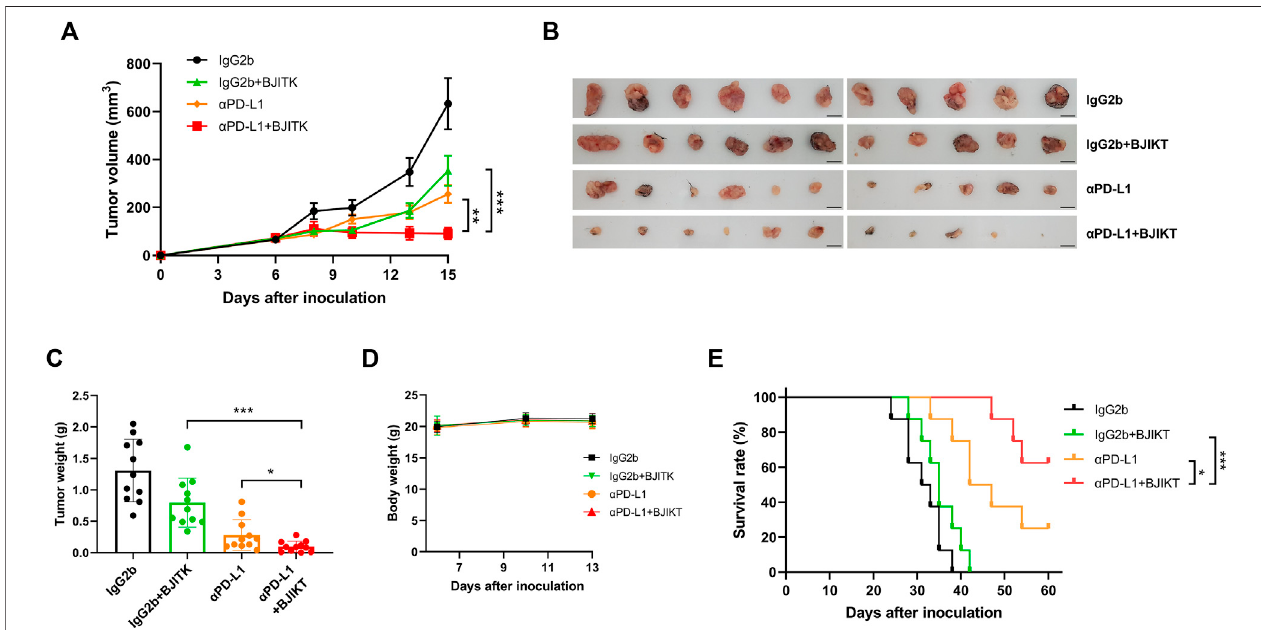
FIGURE 3 | BJIKT combined with anti-PD-L1 ( α PD-L1) antibody dramatically suppressed the tumor growth in the immunocompetent MC38-bearing mice. MC38 cells (5 × 10 5 cells) were injected subcutaneously into C57BL/6 mice. Six days after injection, mice were divided into four groups ( n = 11, each group) as follows: control mice,micewithBJIKT,micewithPD-L1antibody, andmicewithcombinationtreatment(BJIKTandPD-L1antibody). BJIKT (1.0 g/kg)wasorallyadministereddailyand anti-PD-L1 antibody (10 mg/kg) was intraperitoneally injected 3 times a week. (A) Tumor volumes were measured two or three times a week after the treatment in MC38-bearing mice. (B) Tumor images from mice. Scale bar represents 10 mm. (C) Tumor weights were shown. (D) Body weight changes of MC38-bearing mice. (E) TheKaplan – Meiersurvivaldistributioninthemodelisdisplayedforthemicefollowingthetreatment( n =8,eachgroup).* p < 0.05,** p < 0.01,and*** p < 0.001,compared to the combination